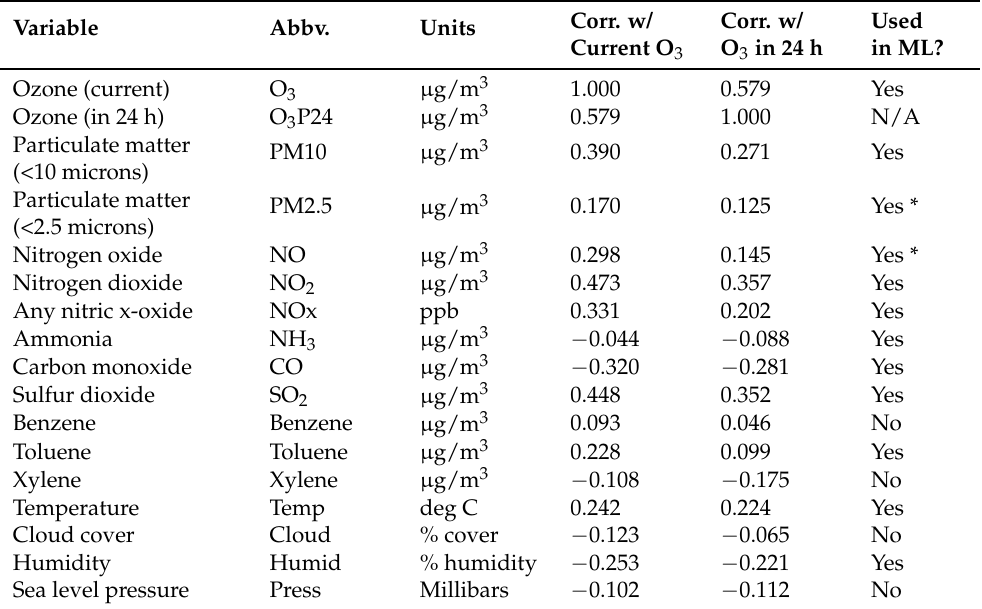
Table 1. List of ozone correlations for the year 2015 of pollutant and weather variables used in this study. Asterisk indicates that the variable was excluded from ML models affected by multi-collinearity (linear regression, SVM, KNN).